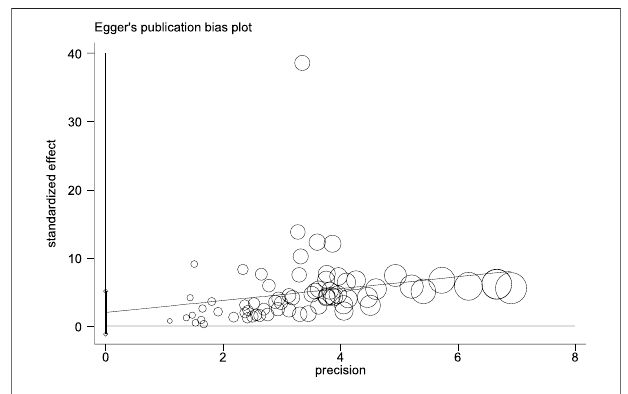
FIGURE 16 | Funnel, Eagers ’ , & Beggs ’ plots for assessment of publication bias.